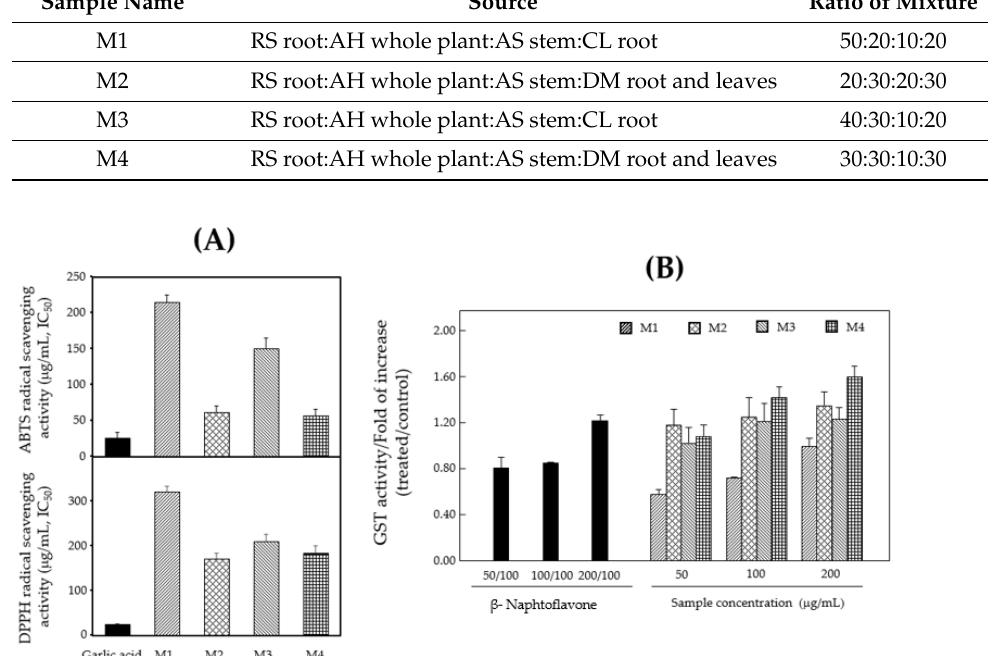
Figure 2. Antioxidant and hepatoprotective effects of each mixture. ( A ) ABTS and DPPH radical scavenging activities. ( B ) GST activity in hepa-lclc7 cells. Data are expressed as means ± SD ( n = 3) of three individual experiments. A value of p -value < 0.05 was considered statistically significant.